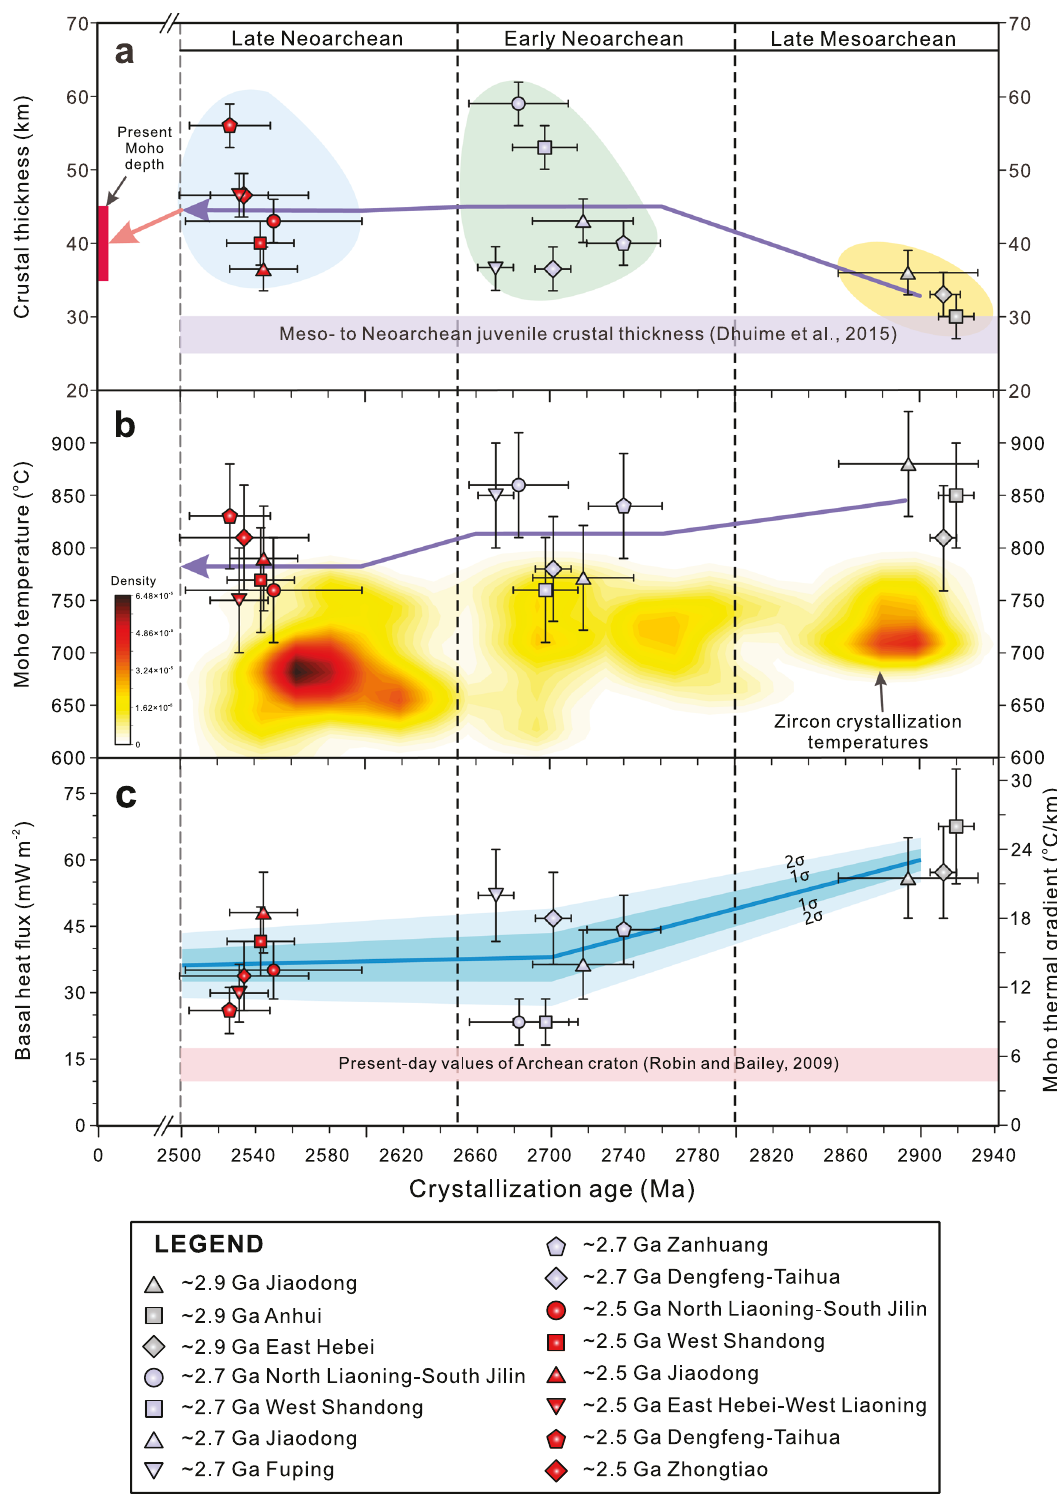
Fig. 5 Changes of calculated crustal thickness, Moho temperature, basal heat fl ux and Moho geothermal gradient during ~2.9 Ga to ~2.5 Ga for the Eastern Block of the North China Craton. a The present Moho depth is from McLennan 64 , and the Meso- to Neoarchean juvenile crustal thickness is from Dhuime et al. 65 . b Zircon crystallization temperatures were calculated by Titanium-in-zircon geothermometer proposed by Ferry and Watson 66 . c The present-day basal heat fl ux values of Archean craton are from Robin and Bailey 67